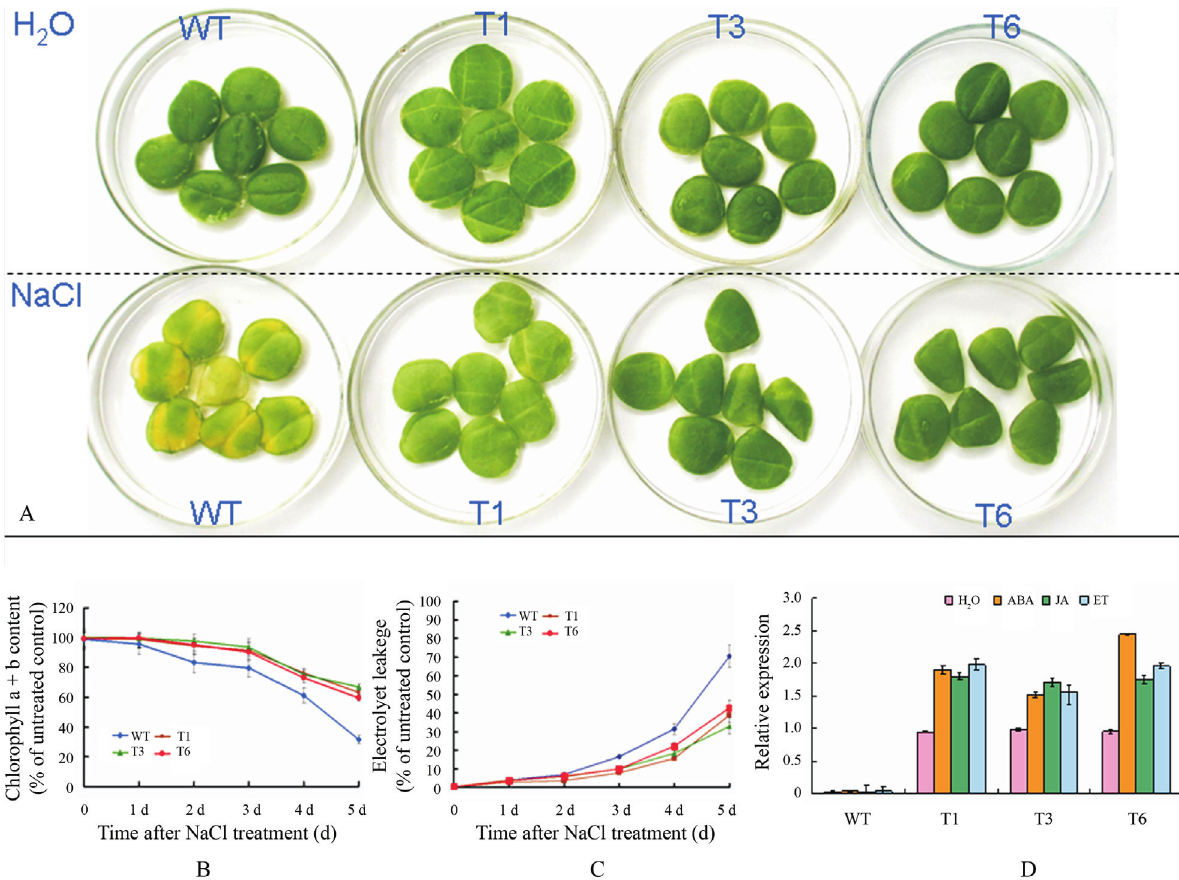
Figure4 - JcR1MYB1 transgenictobaccophenotypesinresponsetosalt.(A)PhenotypeofleafdiscsfromWTandtransgenicplants(T1,T3,andT6lines) aftertreatmentwith200mMNaClfor5d.DetachedleavesfromWTcontrolsweretreatedwithwaterunderthesameconditions.(B)Chlorophyllcontent ofleafdiscsfromWTandtransgenicplants(T1,T3,andT3lines)aftertreatmentwith200mMNaClfor5d.Errorbarsshowstandarddeviationsforthree independentreplicates.(C)ElectrolyteleakageofleafdiscsfromWTandtransgenicplants(T1,T3,andT3lines)aftertreatmentwith200mMNaClfor5 d. Error bars show standard deviations for three independent replicates. (D). Expression of JcR1MYB1 in transgenic tobacco. 100 mM ABA, 50 mM ET, and 100 mM JA was applied to the surface of solid MS agar medium of the 3 wk-old seedlings. After 2 h in each treatment, sample seedlings were